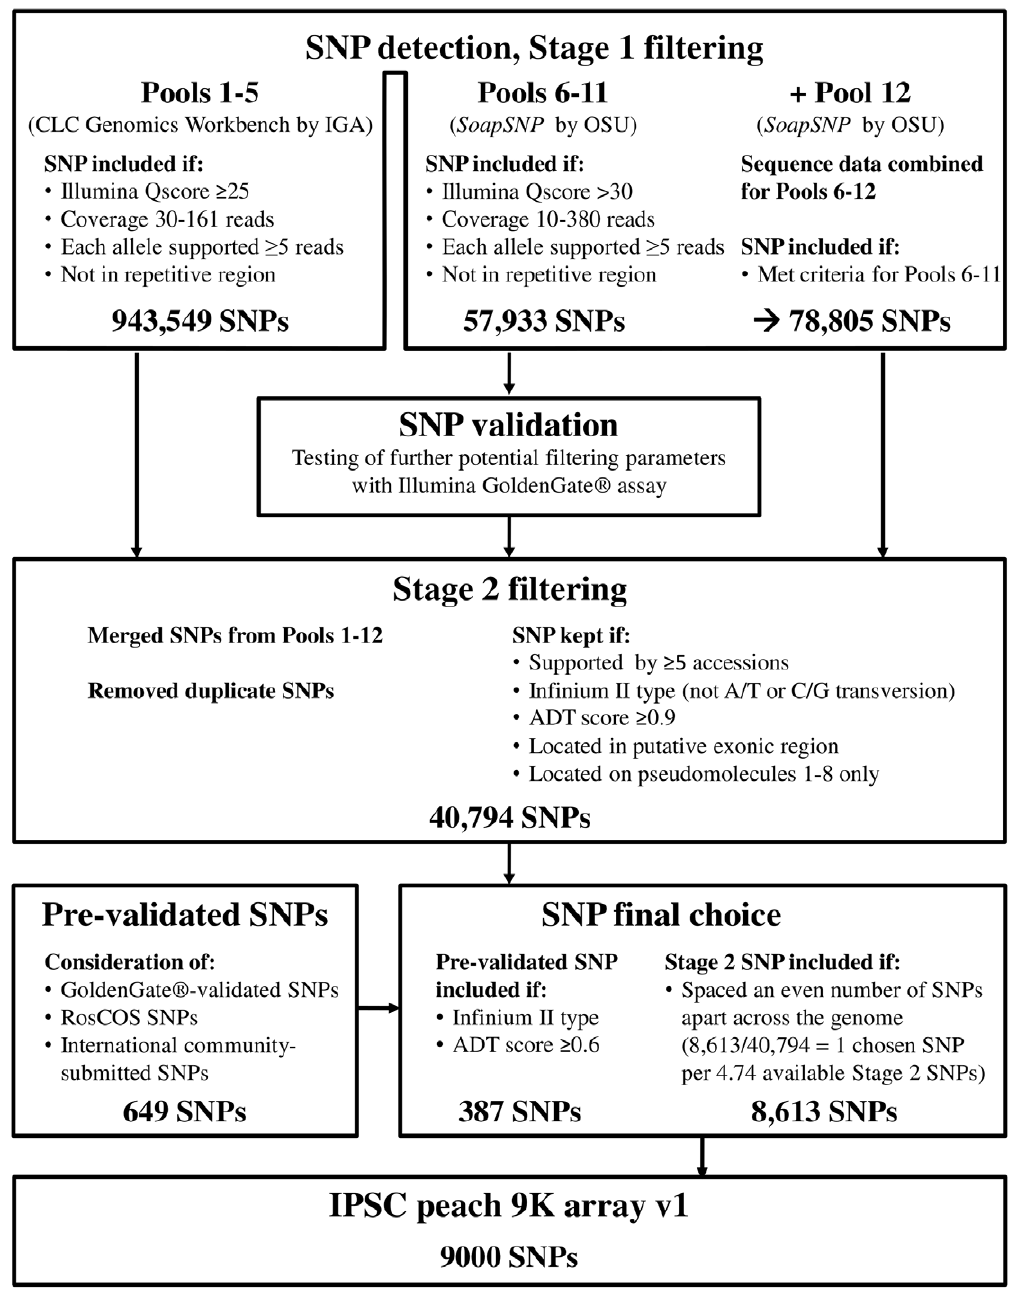
Figure 1. Workflow for SNP detection, validation, filtering, and final choice employed for development of the International Peach SNP Consortium (IPSC) peach 9 K SNP array v1. peach crop and including the 23 accessions in pools 6–11 of the detection panel. The validation panel also included the T 6 E bin- mapping set of six ‘Texas’ almond 6 ‘Earlygold’ peach seedlings and ‘Earlygold’ [25] to enable validation of SNP genomic locations. For a snapshot of SNP polymorphisms in breeding populations, five progenies of six F 1 seedlings were included, with one progeny set each from U.S. peach breeding programs in Arkansas, South Carolina, and Texas, and two from California. Genomic DNA was isolated from each accession using the E-Z 96